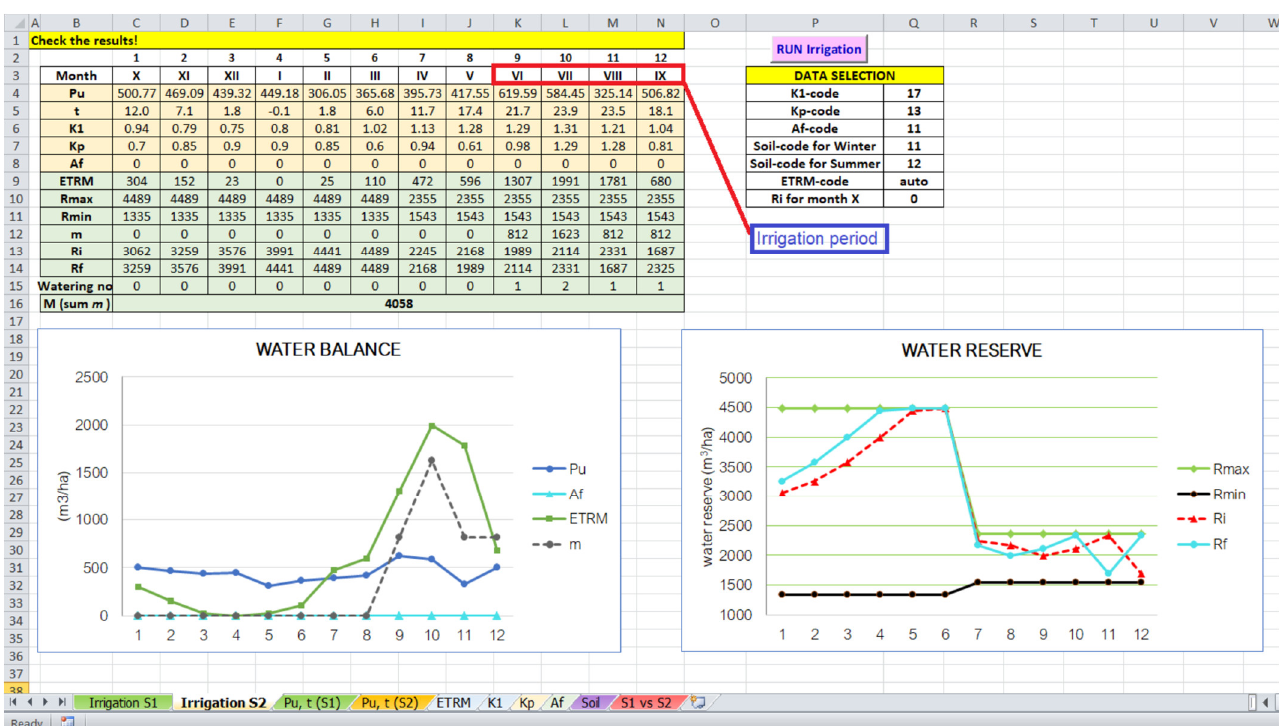
Figure 13. Computation results for TL.